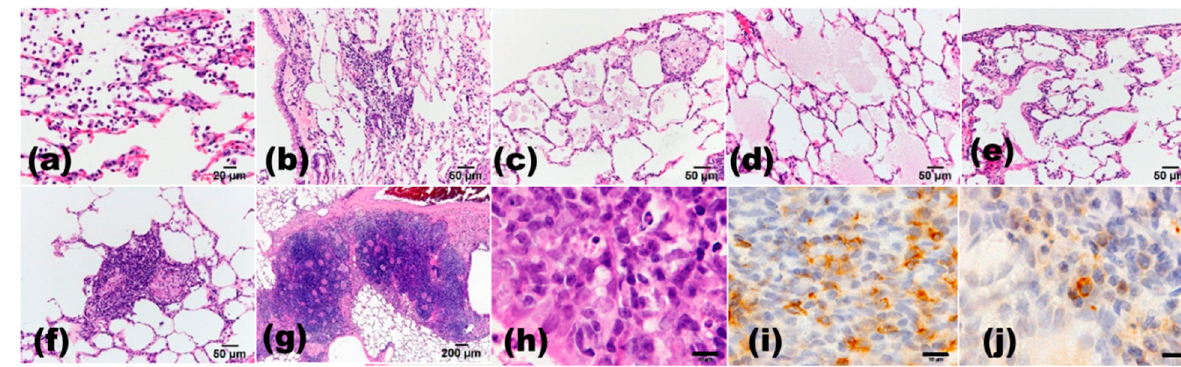
Figure 3. Histopathological findings in quartz (DQ-12, 2 mg/0.2 mL saline/rat i.t., after 24 weeks) -induced inflammatory changes in the rat lungs. ( a ) neutrophil infiltration in the alveolar walls and in the alveolar space; ( b ) lymphocyte infiltration in the alveolar space; ( c ) macrophage infiltration in the alveolar space; ( d ) pulmonary edema; ( e ) pulmonary fibrosis; ( f ) granuloma; ( g ) lymph follicle formation around the bronchiole; ( h – j ), lymphocytes infiltration around bronchiole. Scale bar, ( a ), 20 μ m; ( b – f ), 50 μ m; ( g ), 200 μ m; ( h – j ), 10 μ m. ( a – h ), H&E staining; ( i ), immunohistochemical staining of CD3; ( j ), immunohistochemical staining of CD20.